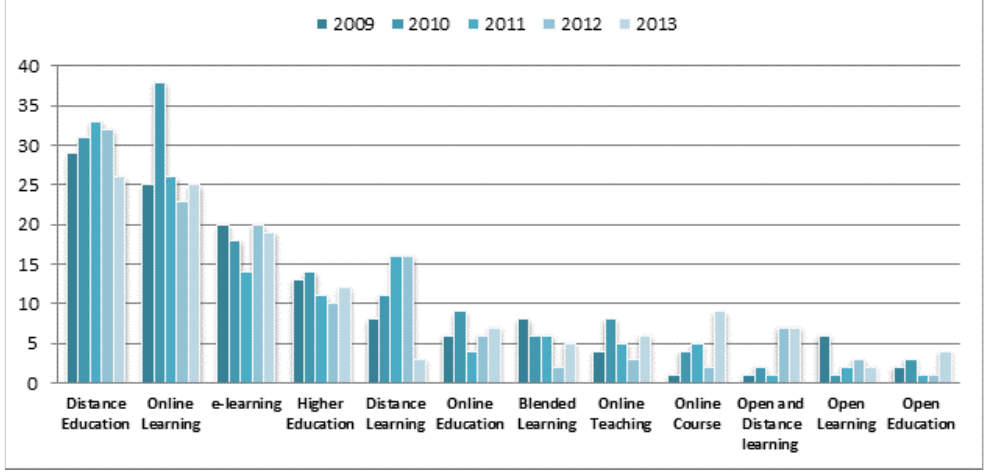
Figure 1. Field specific keywords